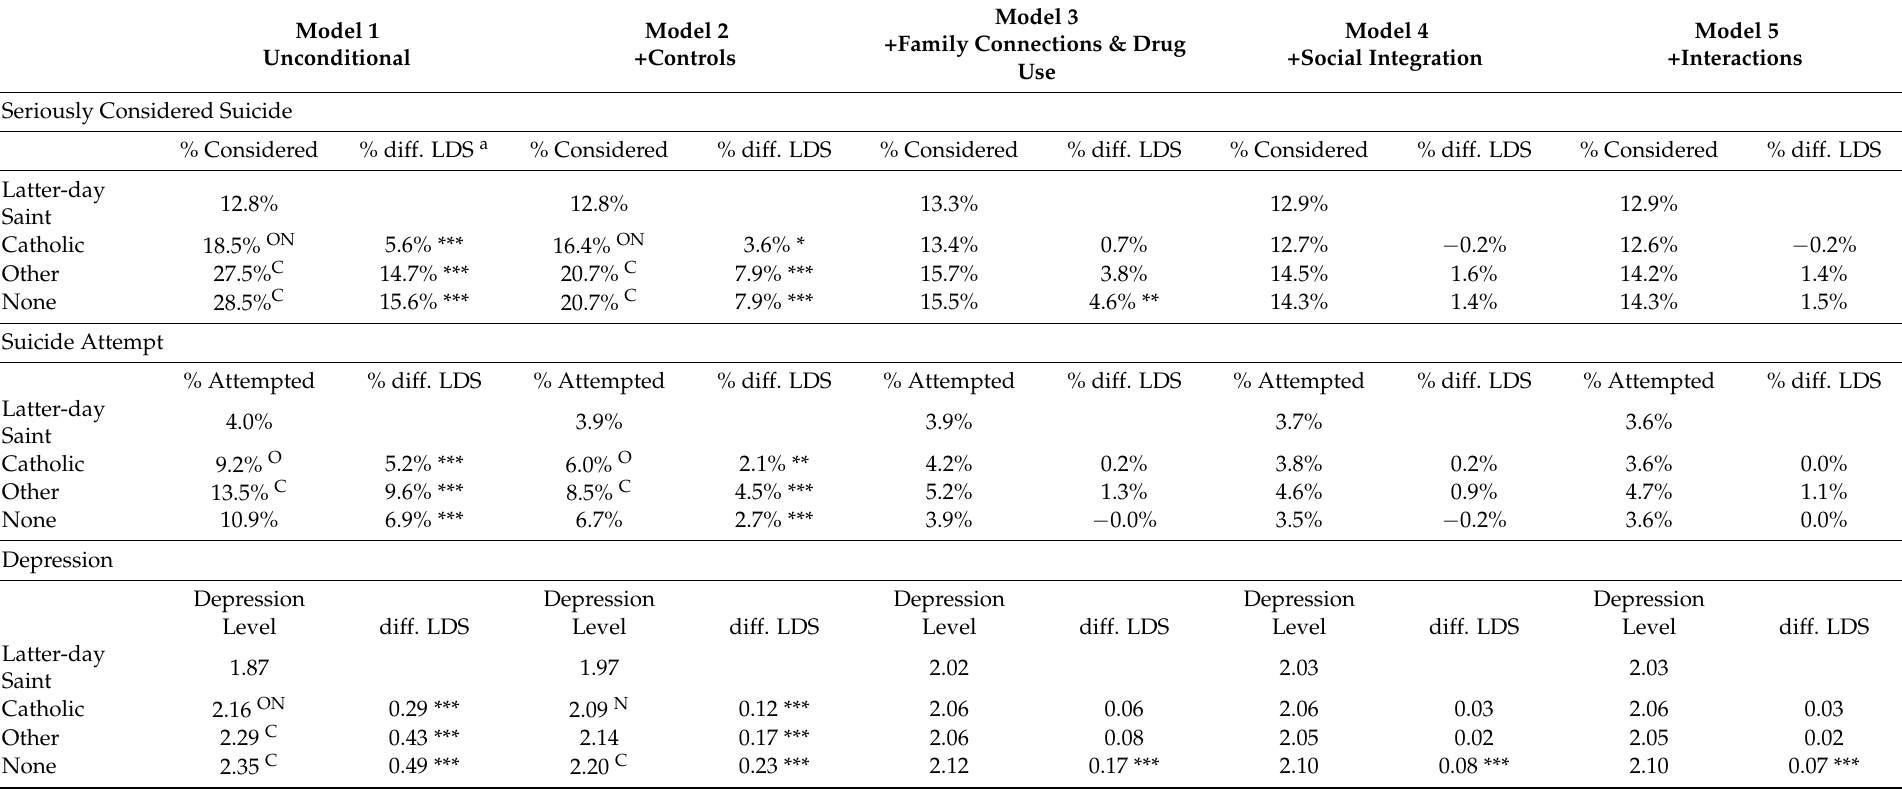
Table 3. Marginal Percentages/Means for Seriously Considered Suicide, Attempted Suicide, and Depression (n = 46,506). Model